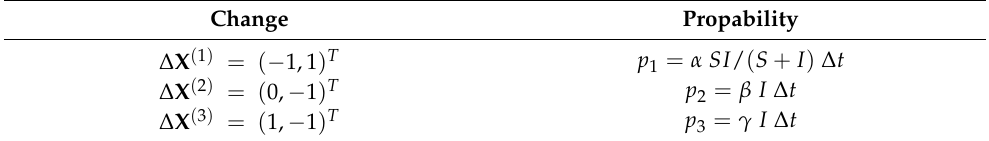
Table 3. Population changes and probabilities of infection, death, and recovery of infected